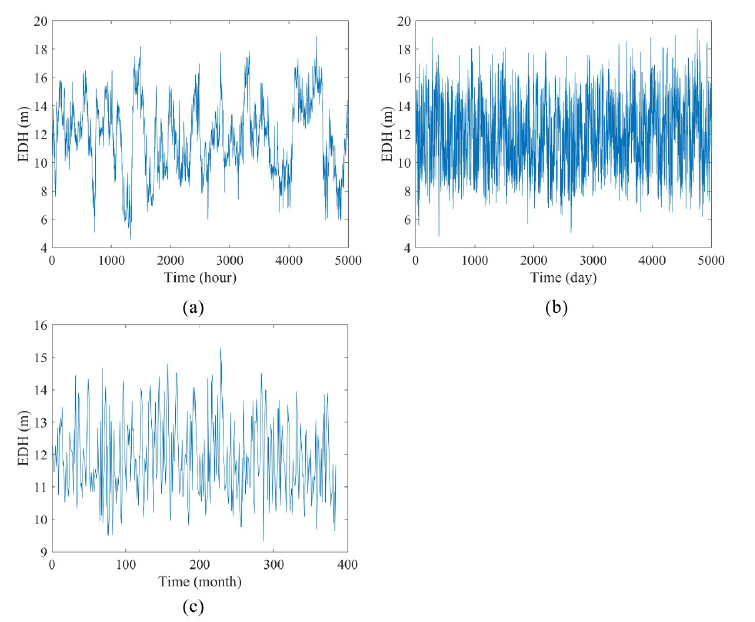
Figure 1. Three datasets of the EDH time series with different timescale:s ( a ) hourly, ( b ) daily, and ( c ) monthly.